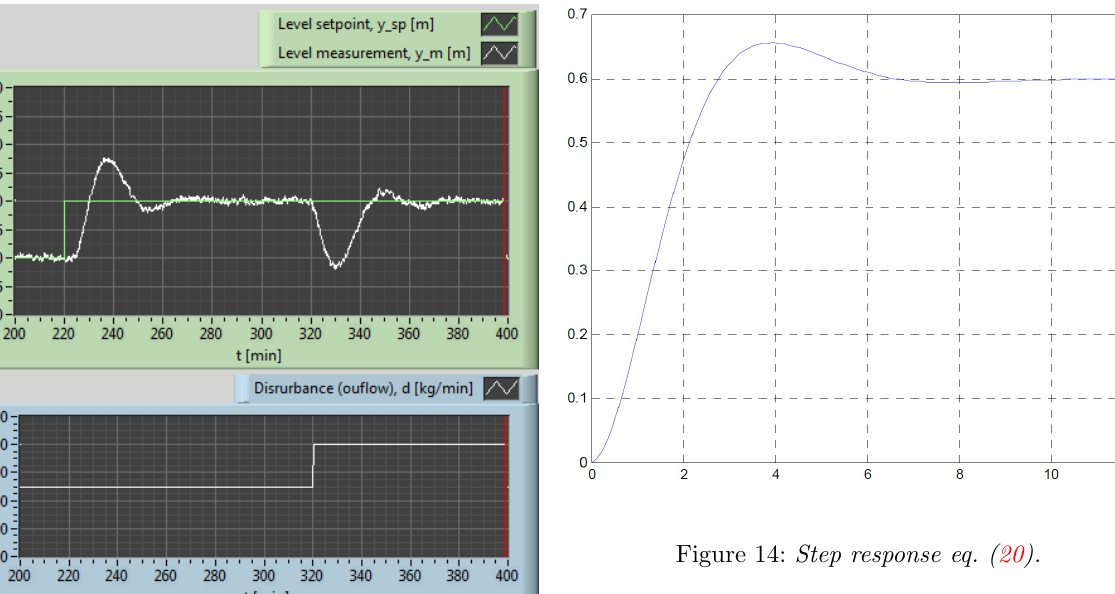
Figure 14: Step response eq.